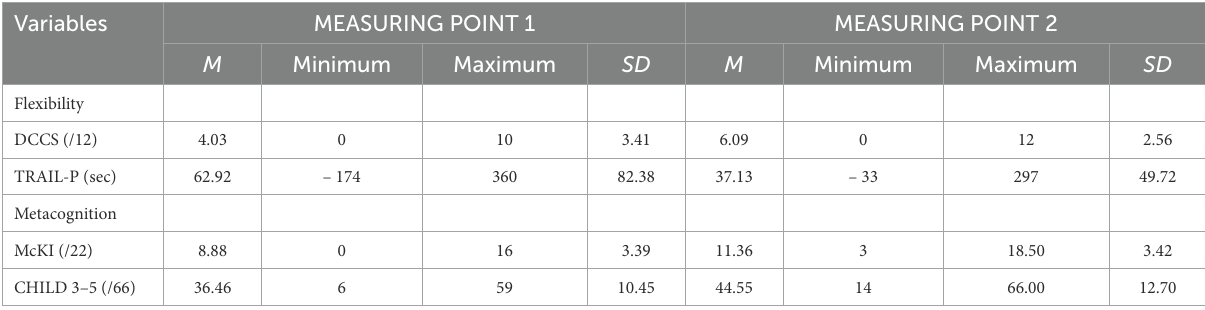
TABLE 2 Descriptive statistics of the dependent variables of study.